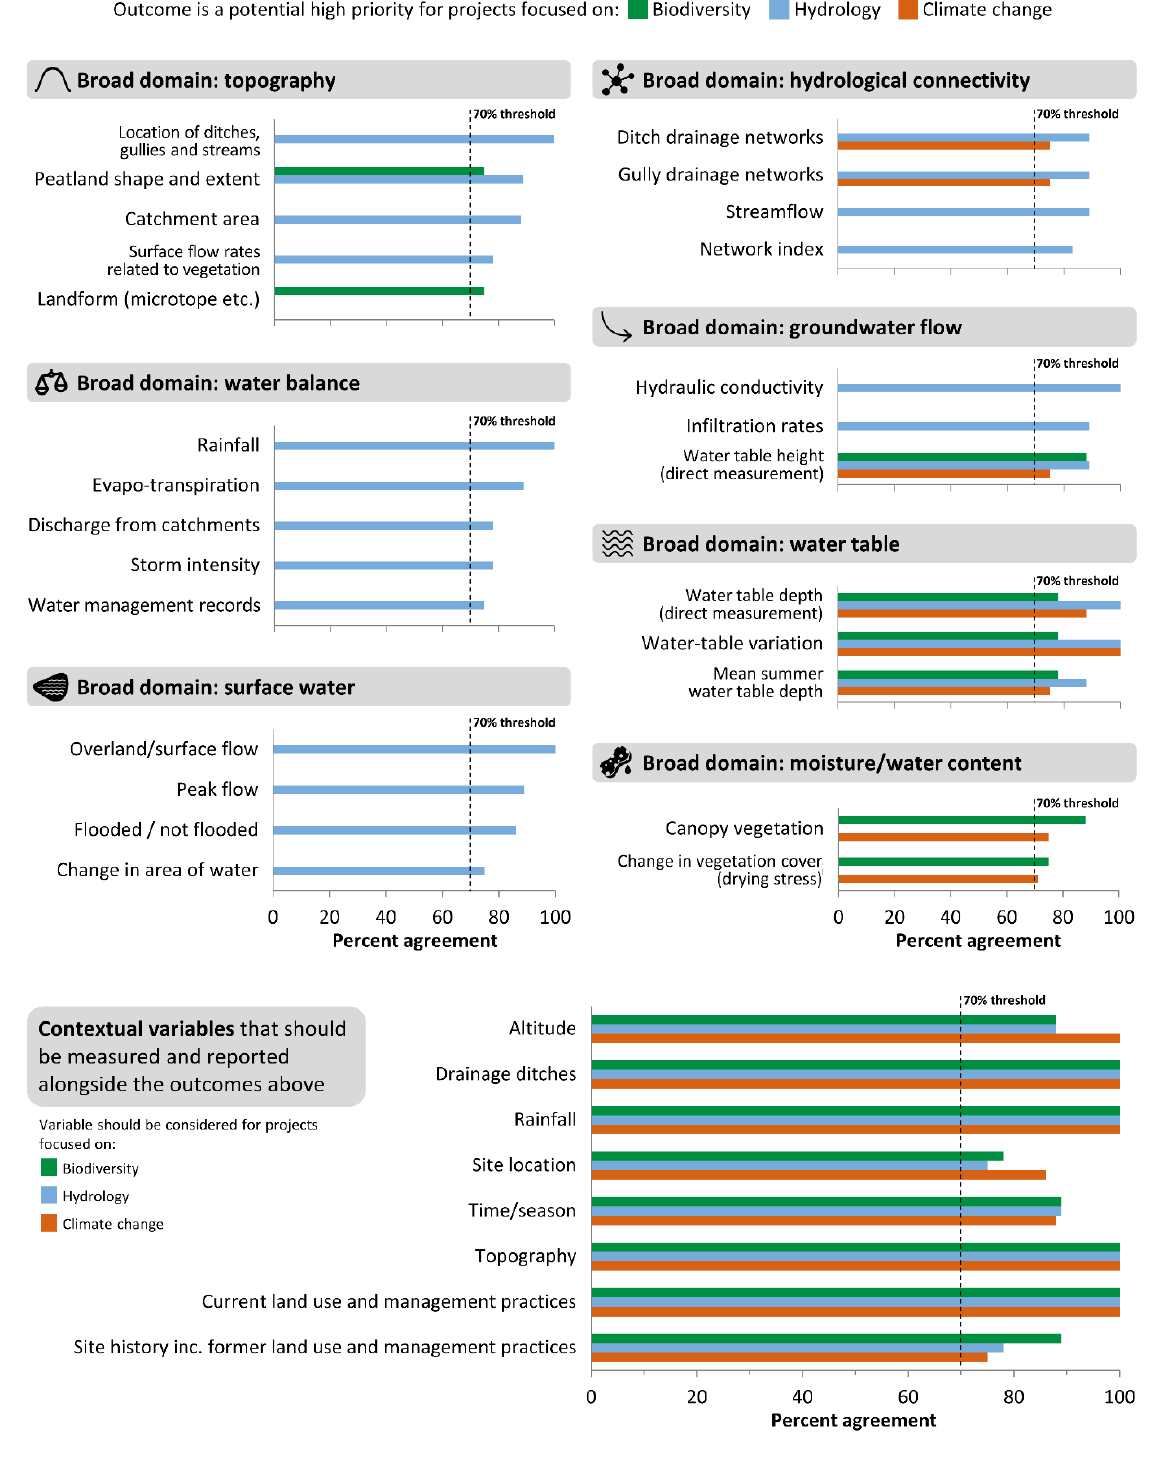
Figure 5. Hydrology core domain set, and the constituent target domain outcomes agreed by ≥ 70 % of respondents as potential high priorities for measurement in UK peatland research or monitoring, depending on the objective or focus of the research or restoration project (based on nine expert responses). Scores < 70 % are not